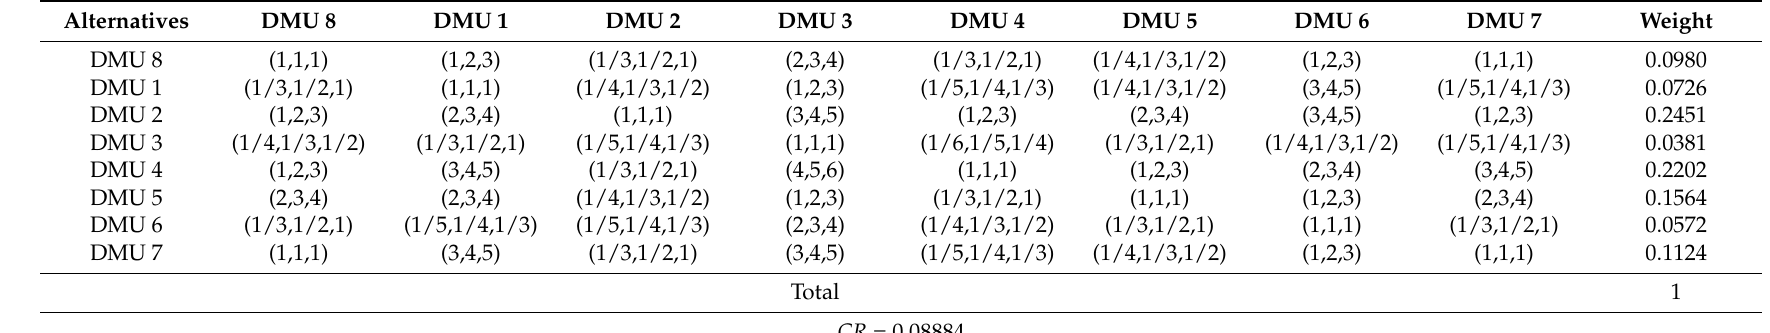
Table A31. Comparison matrix for PUS based on